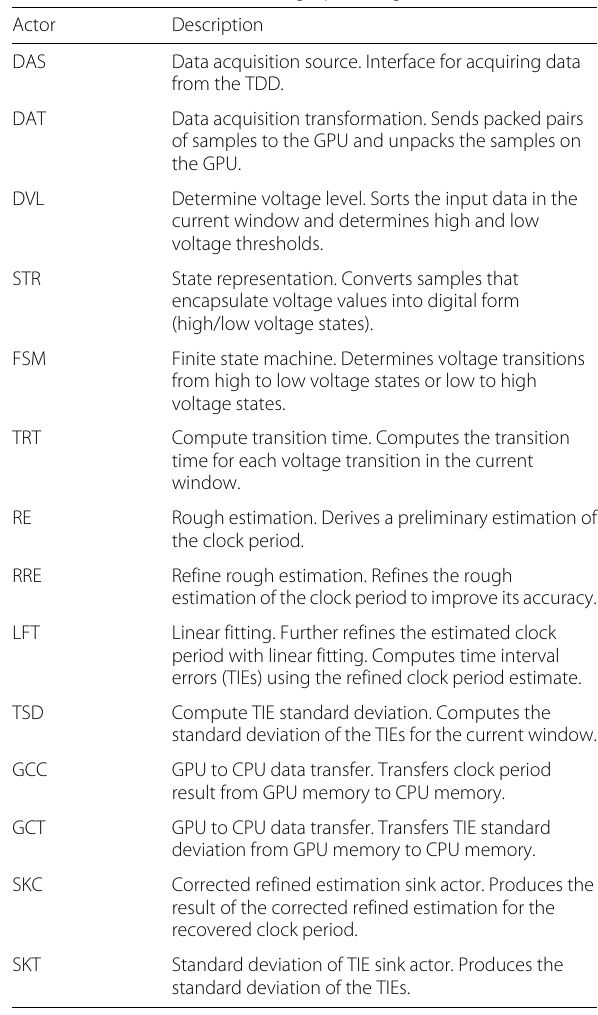
Table 1 Actors in the dataflow graph of Fig.